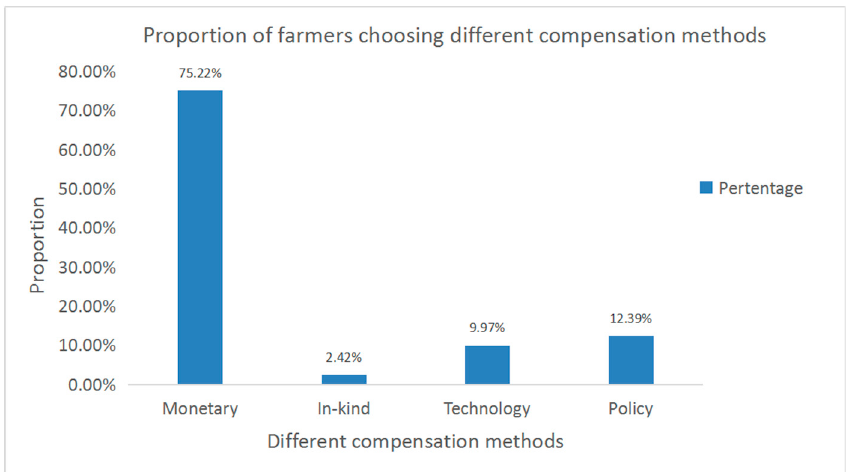
Figure 2. Farmers’ preferences for different farmland eco-compensation methods. Developed based on the farmer’s questionnaire surveys.